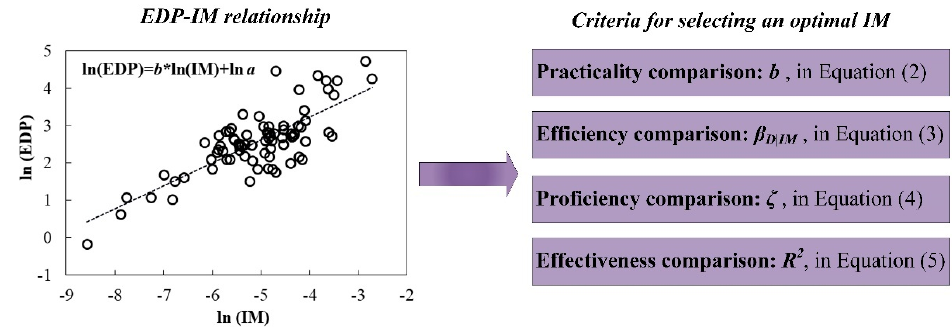
Figure 6. Optimal IM selection criteria.